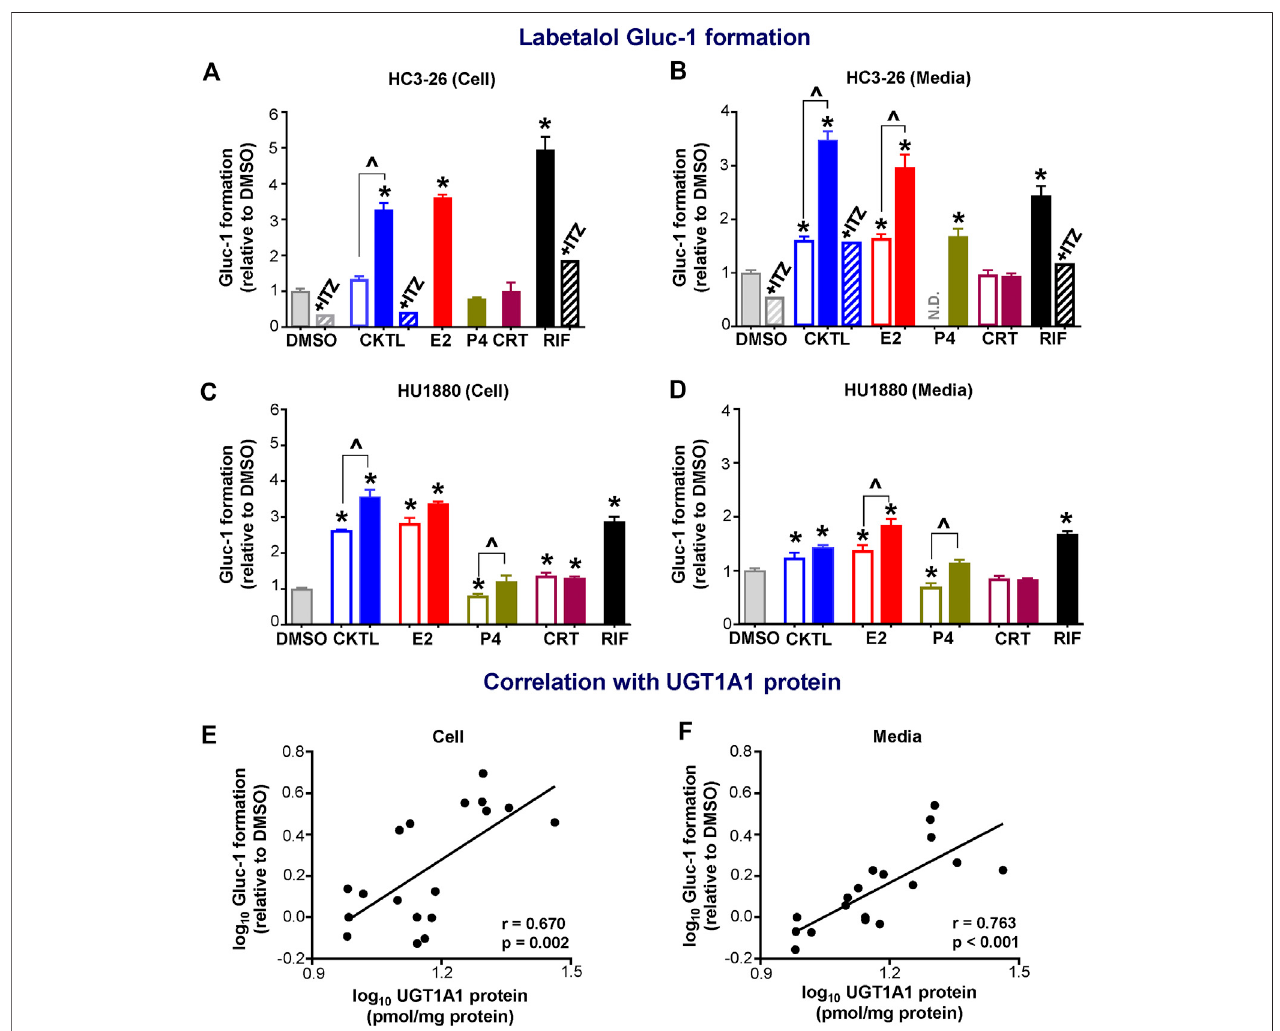
FIGURE 4 | Effect of pregnancy-related hormones (PRH) on labetalol glucuronide (Gluc-1) formation in SCHH. Following 72 h of PRH exposure, SCHH from two donors (HC3-26, HU1880) were incubated with labetalol (1 mM) for 4 h. Labetalol glucuronide (Gluc-1) peak area was measured in both SCHH cell lysates (A, C) and SCHH media (B, D) , normalized to internal standard (labetalol-d 3 ) peak area in each sample, and compared across treatment groups in donor HC3-26 (A: cell lysate, n (cid:2) 3 per group; B: media, n (cid:2) 3 – 6 per group) and donor HU1880 (C: cell lysate, n (cid:2) 4 per group; D: media, n (cid:2) 4 per group). In the donor HC3-26 experiment, cell lysates were not harvested for glucuronide measurements in the 1 µM E2, P4, or CRT groups. Data are calculated as the fold-change in Gluc-1 metabolite formation relative to vehicle control (* p < 0.05 vs. DMSO). Concentration-dependent effects were assessed (open bar: 1 μ M, solid bar: 10 μ M; ^ p < 0.05 1 vs. 10 µM). In the donor HC3-26 experiments, itraconazoleco-administration (+ITZ, 5 μ M) was included in the DMSO-, PRH cocktail (CKTL)-, and rifampin (RIF)-treated groups ( n (cid:2) 1 per group incelllysates; n (cid:2) 2pergroupinmedia)tocon fi rmUGT1A1-mediatedeffects.N.D.,experimentalgroupnotstudied.ThecorrelationbetweenUGT1A1proteinlevelsand labetalol Gluc-1 formation in (E) SCHH cell lysates and (F) SCHH media in both donors is presented. Each data point represents the mean fold-change value for the various treatment groups, relative to DMSO, within each hepatocyte donor. The Pearson correlation coef fi cient (r) and p -value are provided.